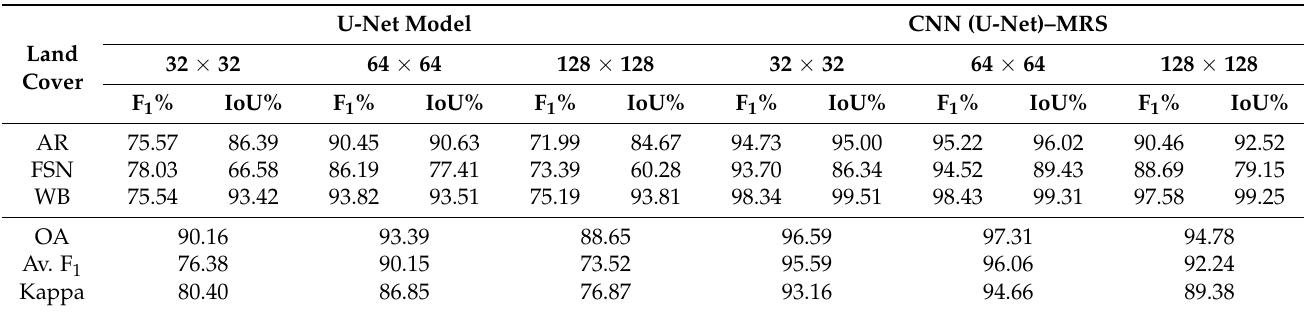
Table 6. Istanbul test site with 5 bands: performance metrics with U-Net.